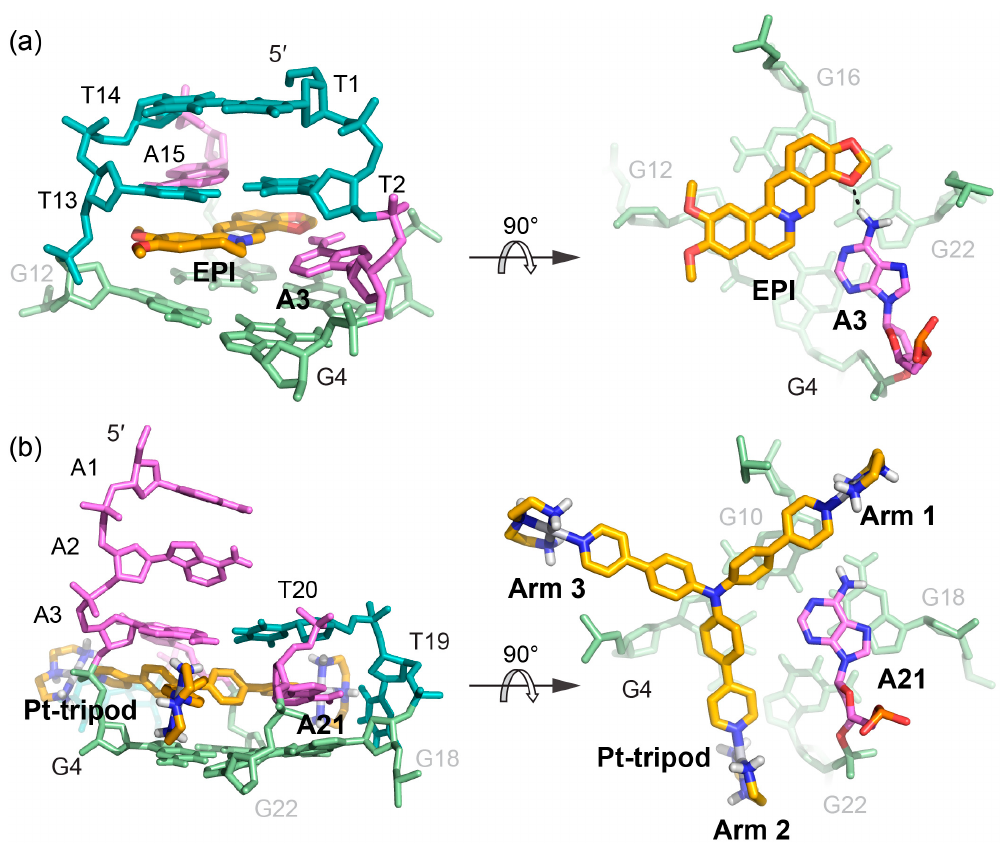
Figure 8. Comparison of the 5 ′ -binding modes between EPI and Pt-tripod with human telomeric hybrid-type G-quadruplexes ( a ) Upon binding, the 5 ′ -flanking A3 is recruited by EPI and forms a quasi-triad plane (right). The multi-layer drug-binding pocket for EPI is formed by the 5 ′ -end flanking residues and TTA lateral loop. (left). Potential hydrogen bond is shown as the black dashed line. ( b ) Upon binding, A21 in the second lateral loop is recruited by Pt-tripod and forms a quasi-triad plane (right), stacking on top of the 5 ′ -external G-tetrad and locking the position of Pt-tripod. Each arm of Pt-tripod stretches into different grooves. The Pt-tripod:A21 plane is capped by the A3:A9:T20 triad (left). Funding: This research was supported by the National Institutes of Health (R01CA122952 (DY), R01CA177585 (DY), and P30CA023168 (Purdue Center for Cancer